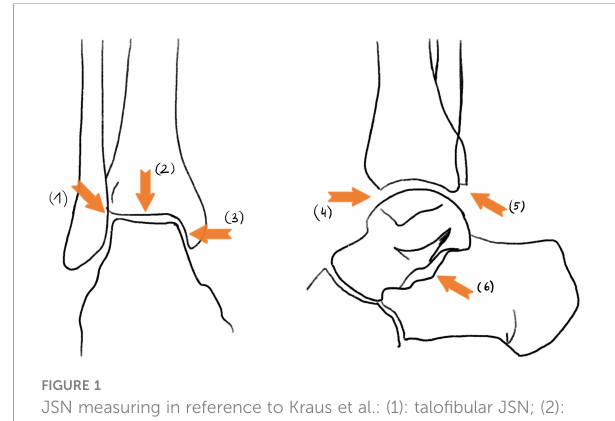
FIGURE 1 JSN measuring in reference to Kraus et al.: (1): talo fi bular JSN; (2): superior tibiotalar JSN; (3): medial tibiotalar JSN; (4): anterior tibiotalar JSN; (5): posterior tibiotalar JSN; (6): subtalar